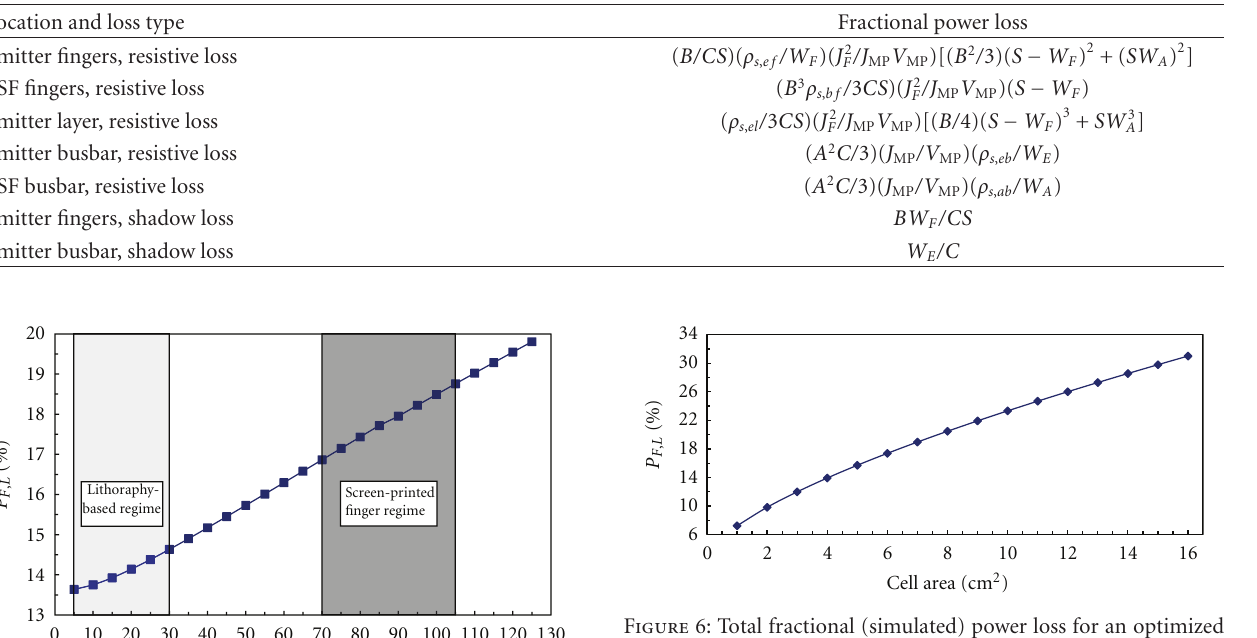
Table 2: Location, loss type, and fractional power loss (i.e., normalized to unit cell area) for the various power loss mechanisms present in interdigitated metallization for poly-Si thin-film solar cells.